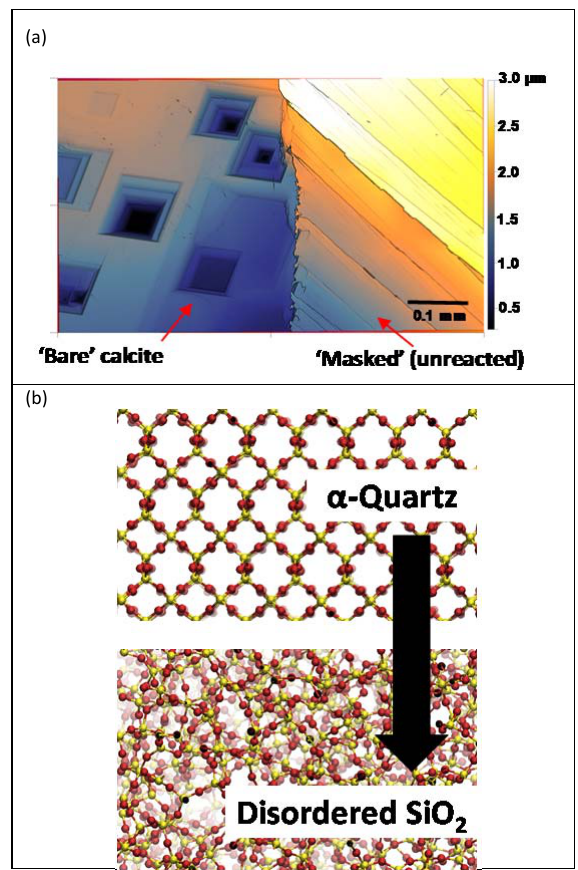
Figure 1. (a) A representative VSI ‐ resolved image of a dissolving calcite (104) surface cleaved from a single crystal that shows the presence of etch pits that propagate deeper into the solid in stepwaves (e.g., see [43]) with increasing dissolution. The dissolution measurements were carried out at pH 5.6 (in DI ‐ water, 18 M Ω∙ cm in equilibrium with air) at 298 K for 15 h wherein a portion of the calcite surface was masked by an inert silicone film and an adjacent area was permitted to dissolve (react). The change in height of the unmasked area vis ‐ à ‐ vis the unmasked reference reveals the dissolution rate (K = ∆ h/ ∆ t, where K is the dissolution rate, and h and t denote height and time, respectively). This image was rendered using Gwyddion [44]. (b) The evolution of α‐ quartz’s periodic (crystalline) structure into disordered silica under energetic particle exposure (red: oxygen atoms, yellow: silicon atoms). The input α‐ quartz structure was sourced from Levien et al. [45] and the disordered structure that results following energetic particle exposure was established via MD simulations [32]. The MD simulations considered an incident particle energy of 600 eV for a computational volume consisting of 8100